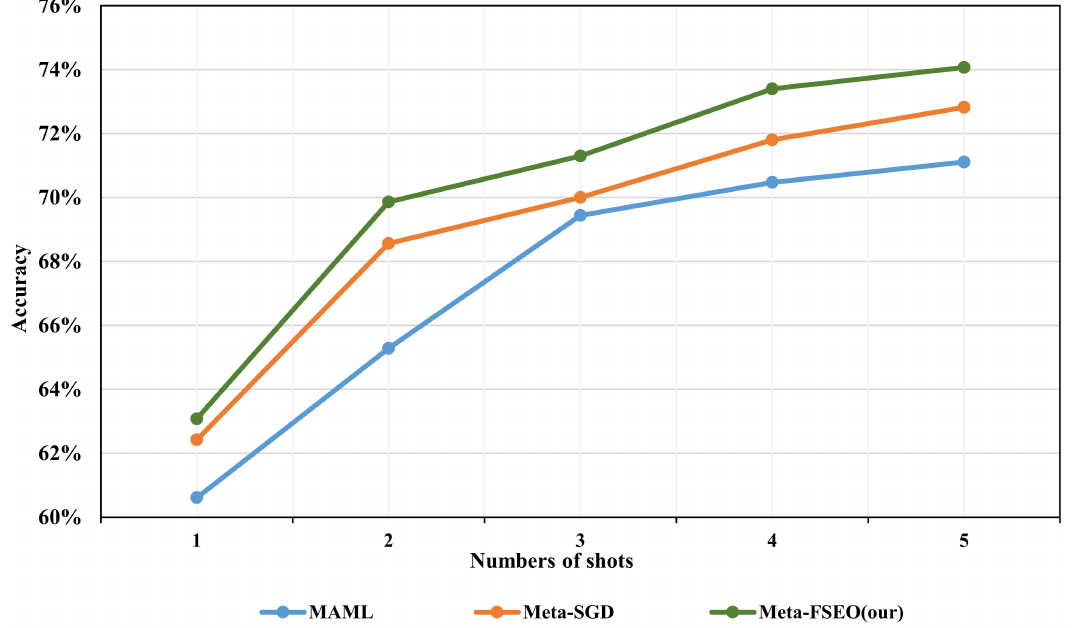
Figure 4. Classification accuracy of the proposed Meta-FSEO compared with MAML and Meta-SGD. The x -axis suggests the number of shots of the meta-test. Given 1–5 labeled samples, our proposed Meta-FSEO outperforms the MAML and